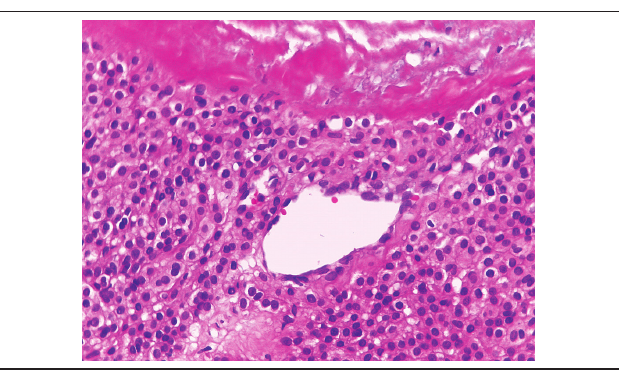
Figura 2 − Histopatologia, 400× HE: células com citoplasma eosinofílico e núcleos uniformes dispostas ao redor de vasos sanguíneos HE: hematoxilina e eosina.